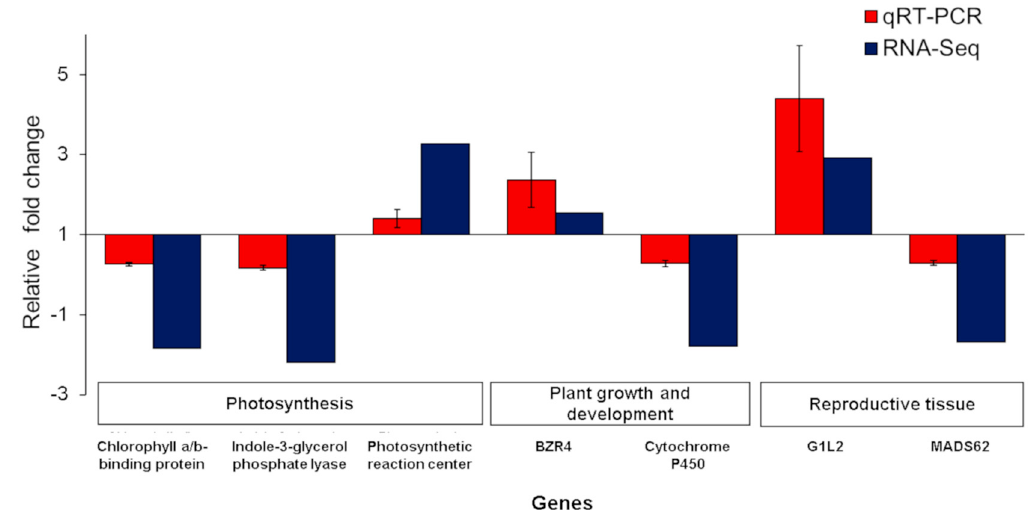
Figure 9. Relative mRNA expression of seven di ff erentially expressed genes in W149 compared with Cypress. Genes plotted are representative of each significant GO term such as photosynthesis, plant growth and development, and reproductive tissue. The y-axis represents the relative mRNA expression value (mean ± standard deviation) from quantitative real-time PCR (qRT-PCR) and RNA-Seq results. Cypress was used as the control and the EF1 α gene was used as the endogenous control. The genes are chlorophyll a / b-binding protein (LOC_Os01g52240), indole-3-glycerol phosphate lyase (LOC_Os03g58290), photosynthetic reaction center protein (LOC_Os10g39880), brassinazole-resistant 1 protein (BZR4) (LOC_Os02g13900), cytochrome P450 (LOC_Os01g24780), G1 Like Protein 2 (G1L2) (LOC_Os06g46030), and OsMADS62 (LOC_Os08g38590).